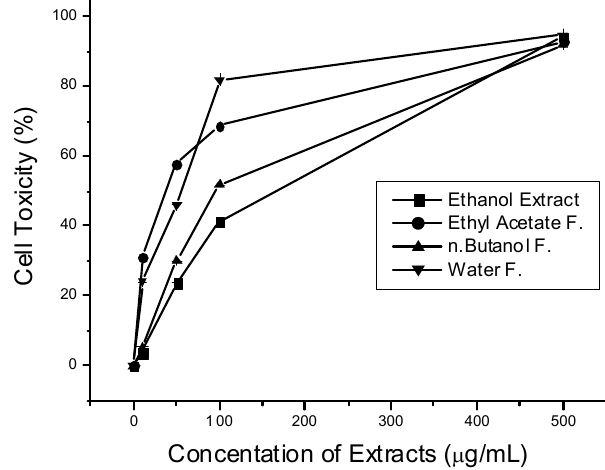
Figure 2. Cytotoxic effect of ethanol extract and partitioning fractions of Leptadenia pyrotechnica on MCF-7 breast cancer cells. Cell toxicity was measured by MTT assay. Data are means of percentage changes of